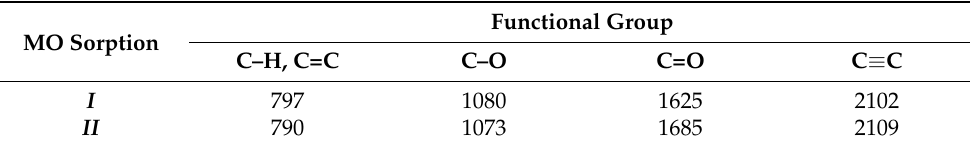
Table 2. FTIR spectra of MnO 2 /PF biochar before and after MO sorption ( I , before MO sorption and II , after MO sorption).